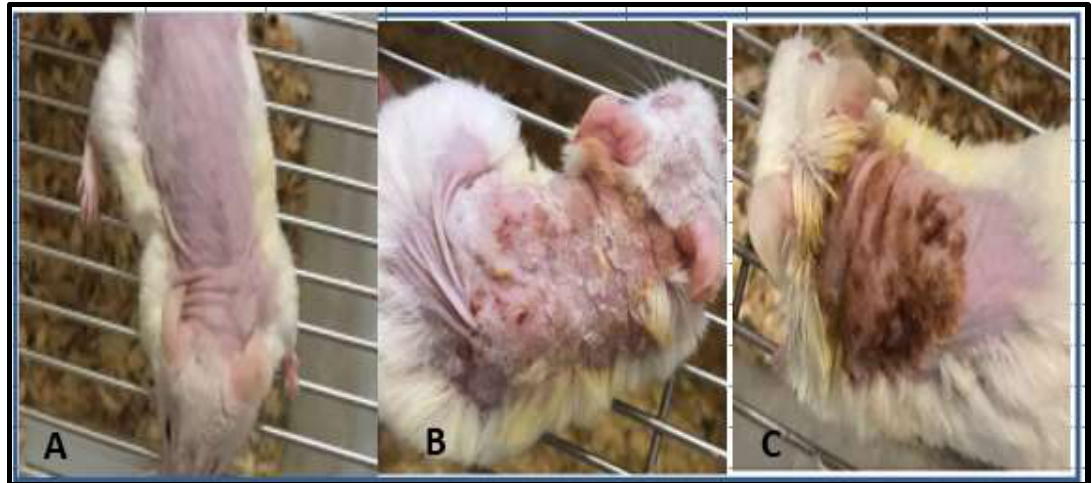
Figure 1. Normal skin lesion without induction (A), Induced atopic dermatitis skin lesion (B) (C). Plant